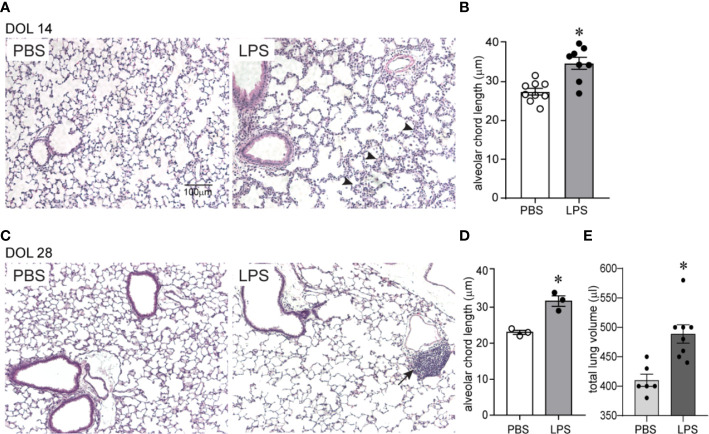
Chronic airway LPS exposure induces persistent hypoalveolarization in immature mice. Immature C57BL/6J mice were inoculated with 3 µg/10 µl of LPS from E.coli O26:B6 or equal volume endotoxin-free PBS intranasally on days of life 3, 5, 7, and 10. Lung histology was assessed on days of life 14 and 28. Representative lung sections were stained with hematoxylin and eosin. Compared to PBS-exposed mice, LPS-exposed mice demonstrated increased alveolar size indicative of alveolar simplification both on day of life 14 (A) and 28 (C). Hypoalveolarization in LPS-exposed mice was associated with a statistically significant increase in alveolar chord length both on day of life 14 (B) and 28 (D). N = 8–9 per group for day of life 14 and three per group for day of life 28, mean ± SEM, *different from PBS-exposed group, *P < 0.05, unpaired t-test. LPS-exposed lungs also showed leukocyte infiltration within the interstitium and in the alveolar spaces (arrowheads in A) on day of life 14 and collection of mononuclear cells, resembling BALT, in the perivascular space (arrows in C) on day of life 28. (E) On day of life 28, the total lung volume of LPS-treated lungs was significantly higher compared to PBS-treated lungs. *different from PBS-exposed group, *P < 0.01, unpaired t-test.